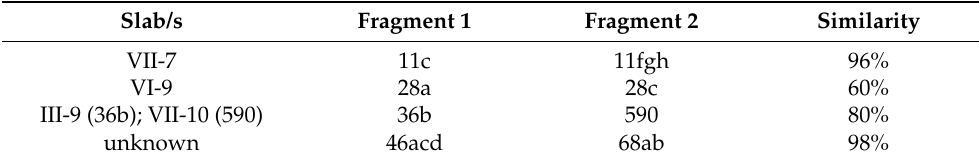
Table 5. Similarity between the averaged CL color of pairs of fragments that in some F.U. reconstruc- tions are hypothesized as belonging to a same